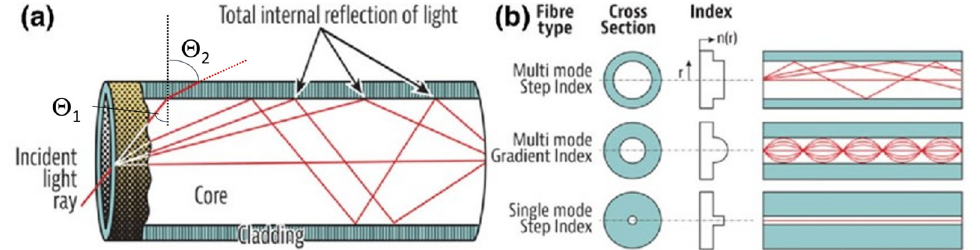
Figure 3. ( a ) The TIR mechanism and ( b ) the typical structure of multi-mode (MM) fibers with a larger core able to propagate multiple modes, and single-mode (SM), which are the most common with a small core[23].